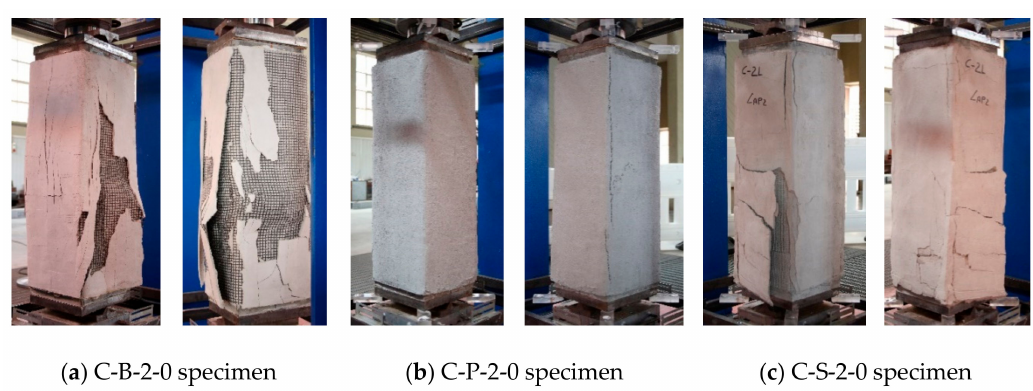
Figure 8. Failure configurations of one layer confined columns.